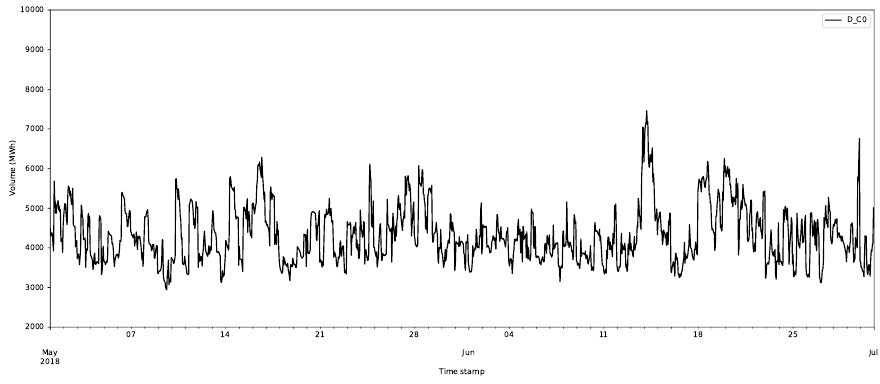
Figure 6. Sample of the volume time series for the first class, D_C0, for the demand.